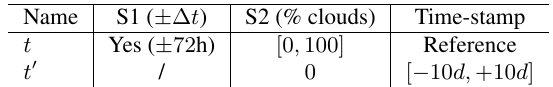
optical image ( S 2 t (cid:48)